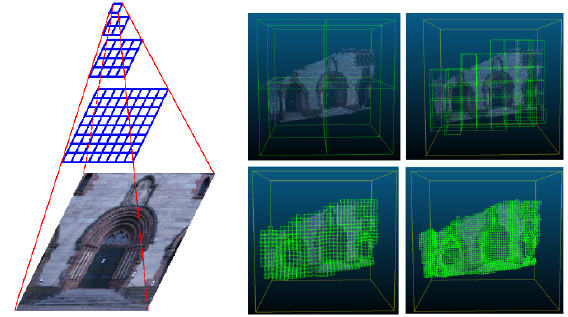
Figure 4. The schematic of pyramid image (left) and octree point cloud (right).